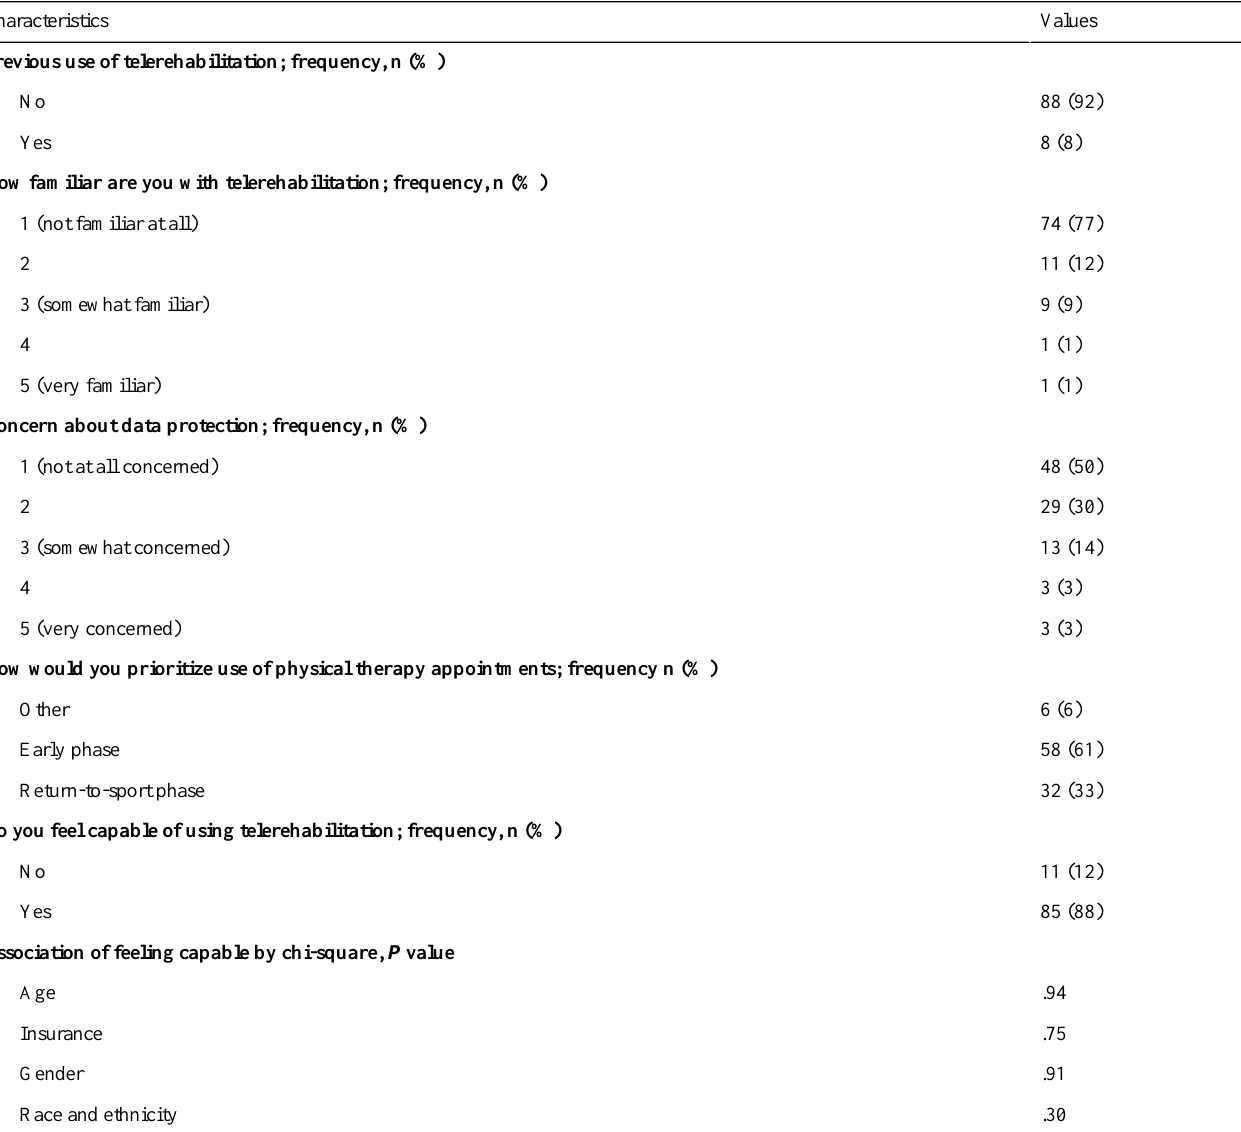
Table 2. Experiences and opinions on telerehabilitation quantitative data (N=96).